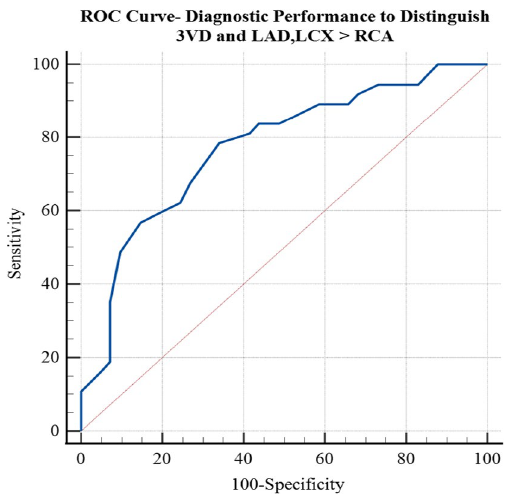
Fig. 12 ROC curve for diagnosis of patients with severe three-vessel and/or left coronary system